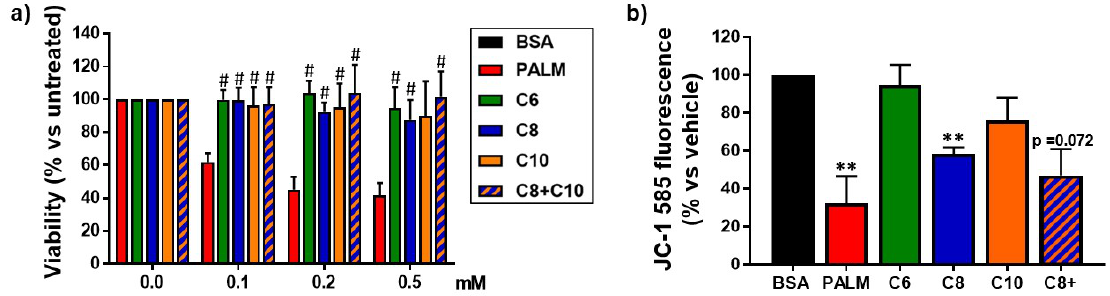
Figure 1. Effect of fatty acids on HepG2 cell viability and mitochondrial membrane potential. HepG2 cells were treated for 24 h with palmitate (PALM), C6, C8, C10, a C8 + C10 equimolar mix, or vehicle control (BSA). ( a ) Quantitative analysis of MTT cell viability assay results ( n = 3) relative to untreated cells (0.0 mM). # p -value < 0.05 versus palmitate treatment. ( b ) Mitochondrial membrane potential relative to vehicle-treated control, as measured with the JC-1 dye ( n = 3). ** p -value < 0.01 versus BSA control.